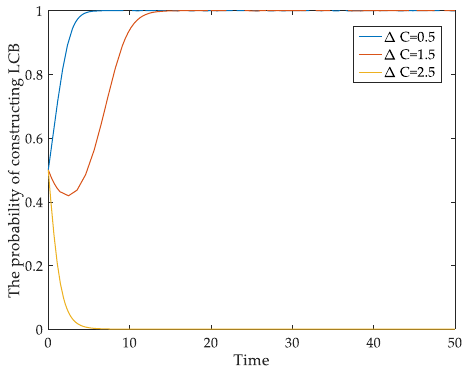
Figure 5. The impact of Δ C on developers’ behavioral evolution.